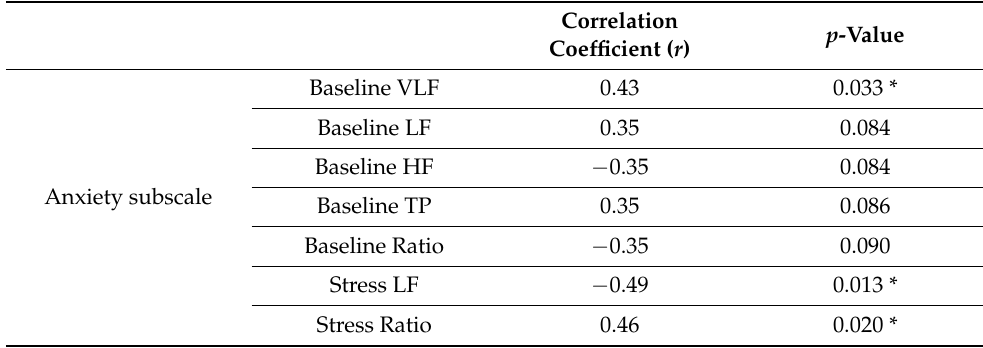
Table 5. Correlation between anxiety subscale (of the DASS tool) and heart rate and heart rate variability data in the general population; with heart rate data recorded with FitBit Versa 2 and heart rate variability data collected from 3-lead